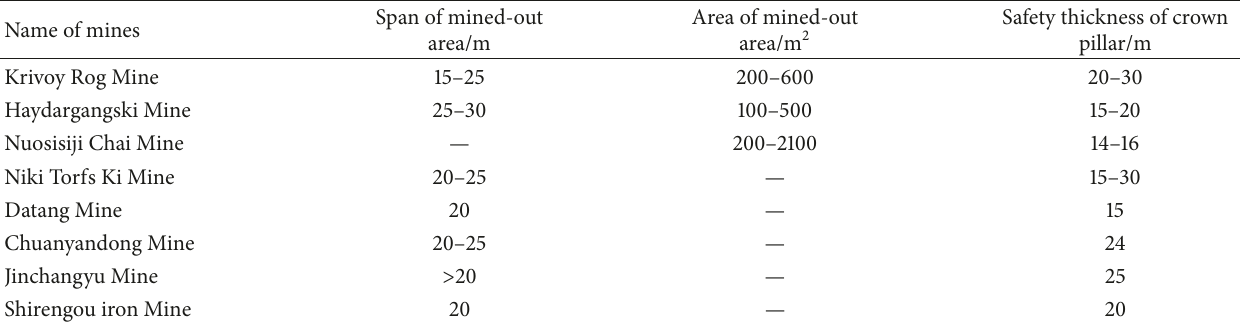
Table 3: Statistics of boundary pillar thickness in comparable mines.